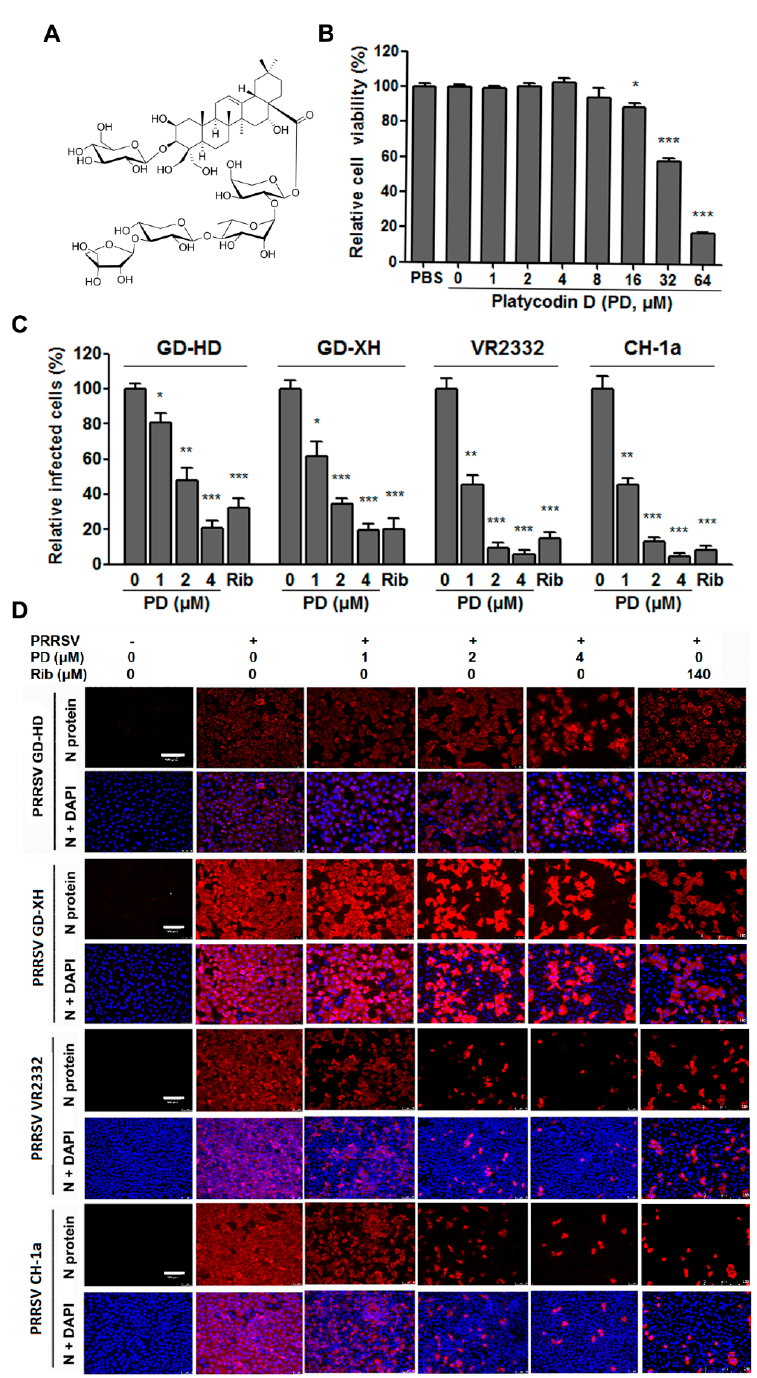
Figure 1. The cellular toxicity and anti-PRRSV activity of PD in MARC-145 cell cultures. ( A ) Chemical structures of platycodin D (PD). ( B ) Cellular toxicity of PD was examined in MARC-145 cells using MTT assay and was expressed as relative cell viability of the viable cells in the absence of the compound (set up as 100%). ( C , D ) Antiviral activity of PD against PRRSV strain (GD-HD, GD-XH, VR2332 and CH-1a) infections in MARC-145 cells was examined using immunofluorescence assay (IFA). Cells grown in 96-well plates were infected with PRRSV (0.05 MOI) for 2 h at 37 ◦ C and then cultured in fresh medium containing various concentrations of PD. IFA for the N protein of PRRSV was performed at 48 hpi using Alexa Fluor 568-conjugated goat anti-mouse secondary antibody (red). Nuclei were counterstained using 4,6-diamidino-2-phenylindole (DAPI) (blue). Results shown in C are the mean values of percentages of PRRSV-infected cell ratio in PD-treated groups compared to the DMSO-treated control (0 µ M PD, set as 100%) from three independent IFA experiments, and D is one representative IFA data from C . Scale bar: 100 µ m. Statistical significances are denoted by * p < 0.05, ** p < 0.01, and *** p <